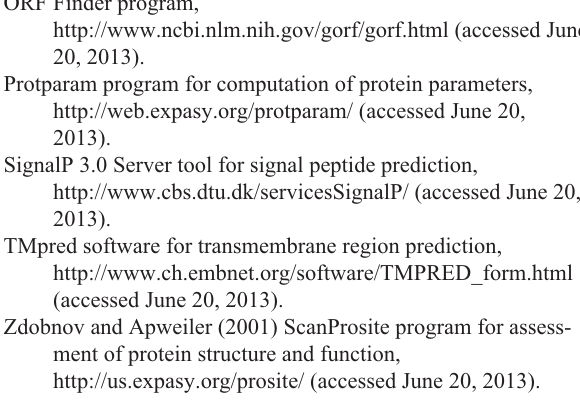
Figure S1 - Multiple sequence alignment of SERK family protein kinases. Figure S2 - Sequence analysis of AcSERK3. Figure S3 - Exon/intron structure of AcSERK3 . Figure S4 - Phylogenetic tree of SERK family